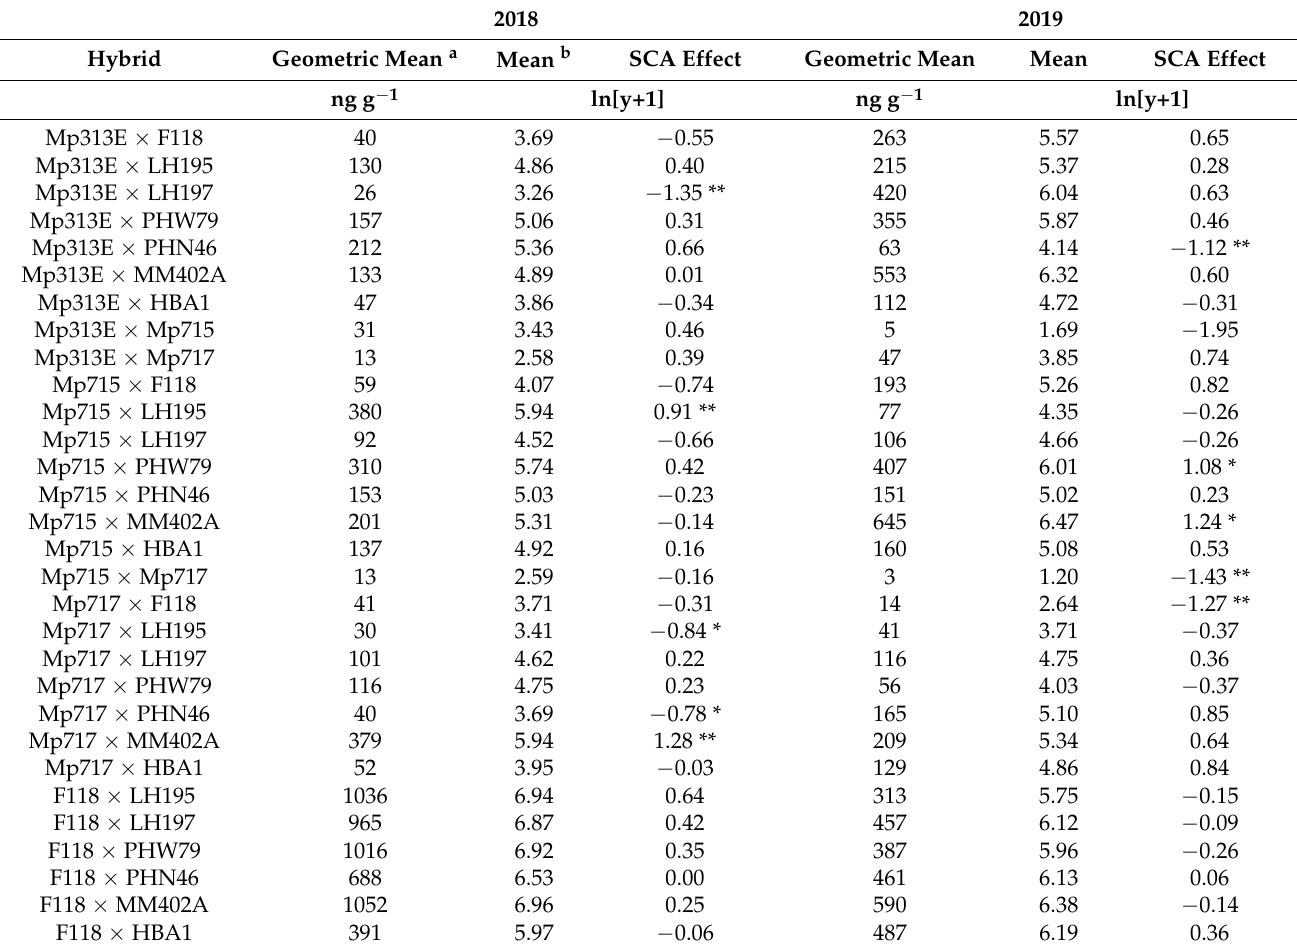
Table 5. Mean aflatoxin accumulation and estimates of specific combining ability (SCA) for F 1 hybrids comprising a diallel